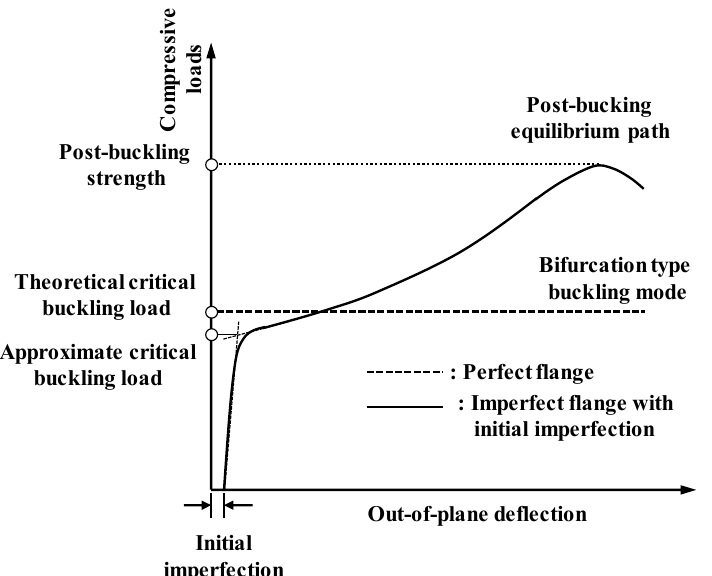
Figure 4. Typical local buckling behavior of thin-walled members in perfect and imperfect flanges.